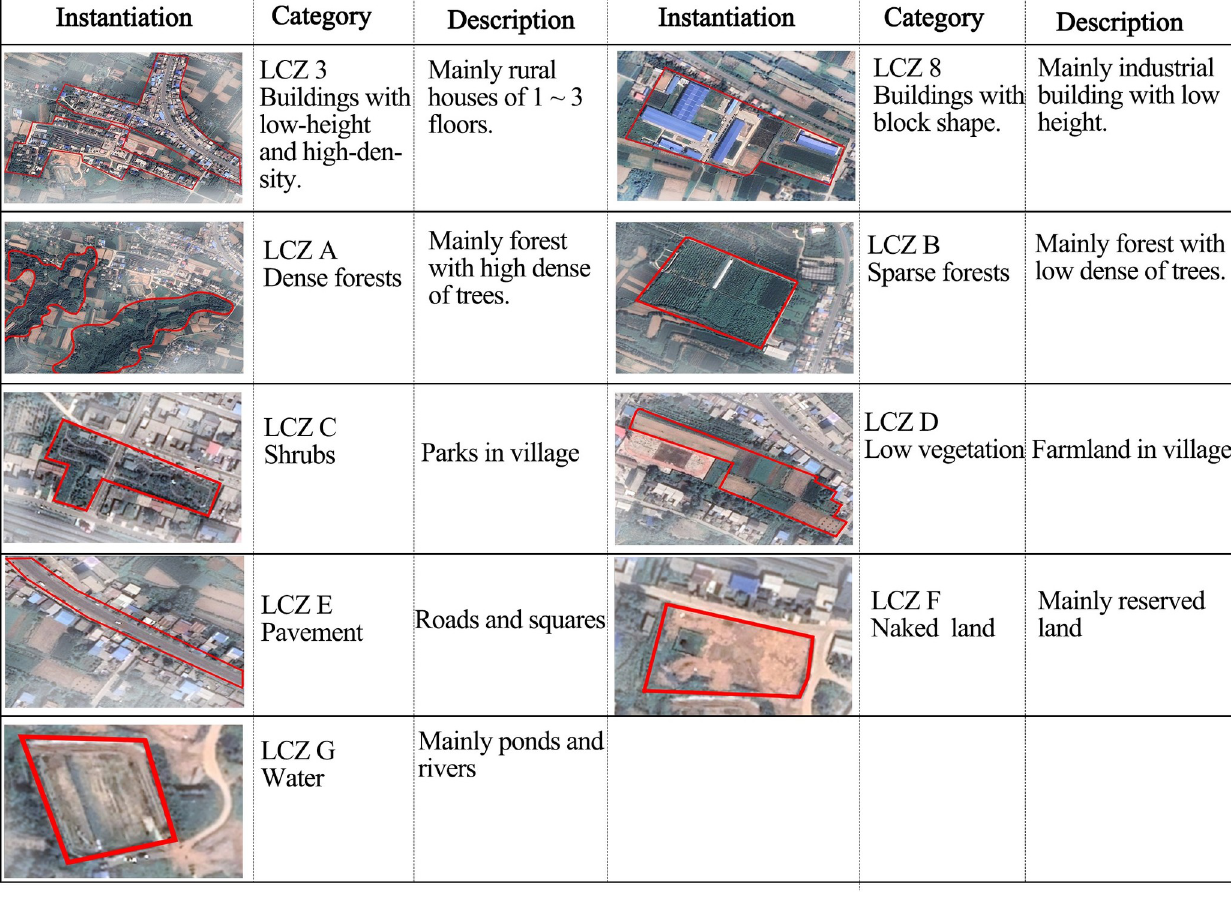
Fig 21. Local Climate Zone (LCZ) zoning system in Villages—a case study of Maling.